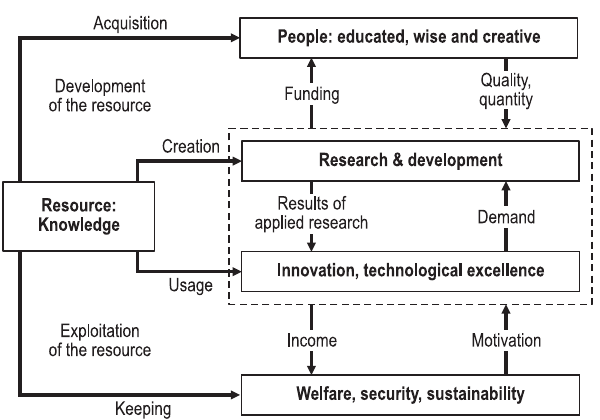
Fig. 6. National Development Plan: action lines